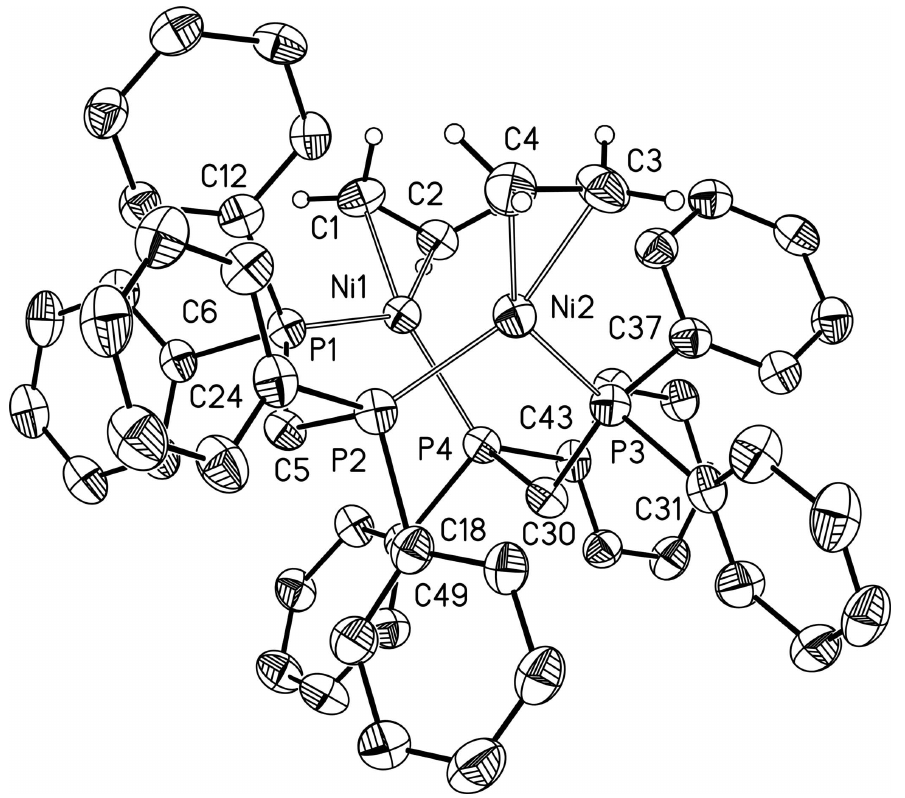
Molecular structure of 1 . Displacement ellipsoids are drawn at the 40% probability level. Except for the ethene ligands, all H atoms have been omitted for